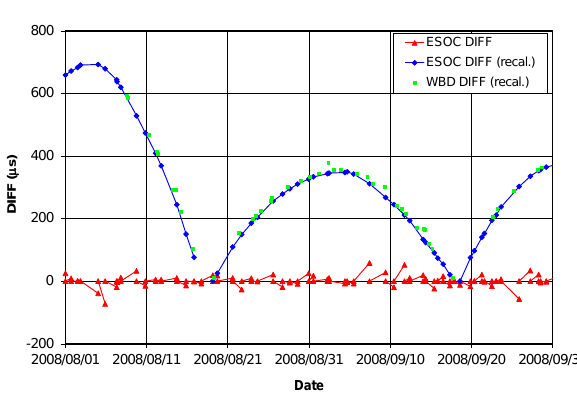
Fig. 2. Recalibrated DIFF measurements after November 2007. When time calibrations are performed every pass, the DIFF values are small and give no indication of the long-term behaviour of the onboard clock. The recalibrated DIFF has a parabolic form similar to that seen in Fig. 1.